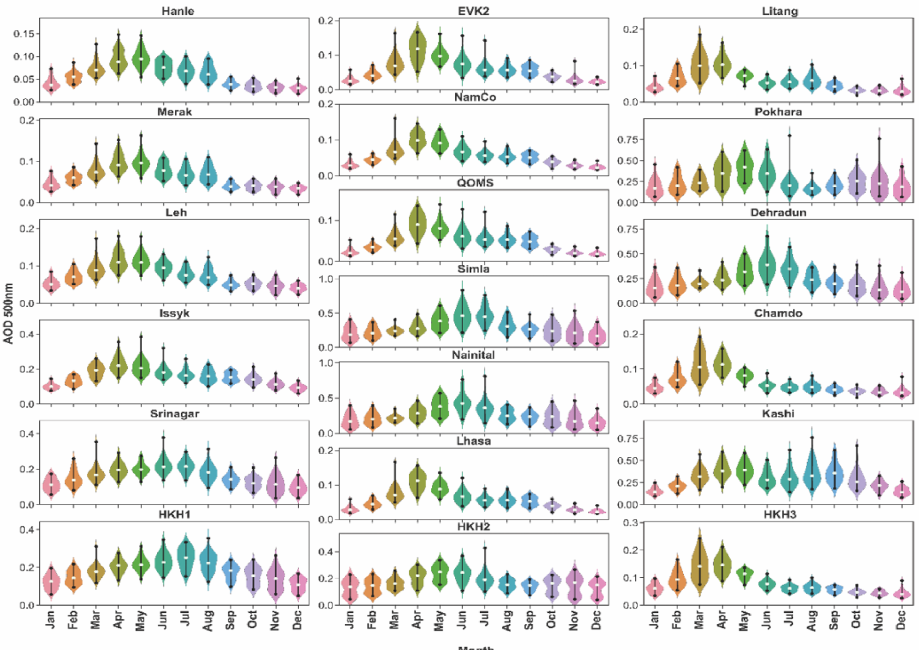
Figure 7. Violin plots of climatological AOD in 1980–2020 from monthly MERRA-2 data. The central circle in white represents the average AOD value, while the solid circle in black at the top and bottom of the violin plot represents the maximum and minimum AOD values,